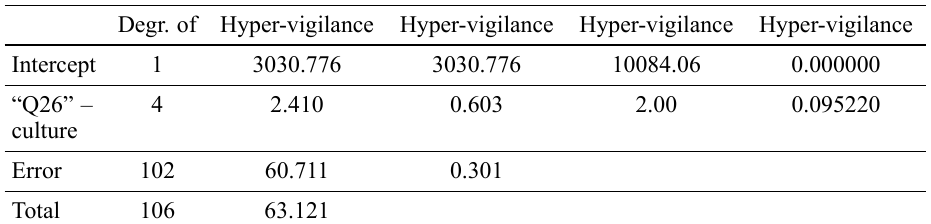
Table 10. Variance analysis